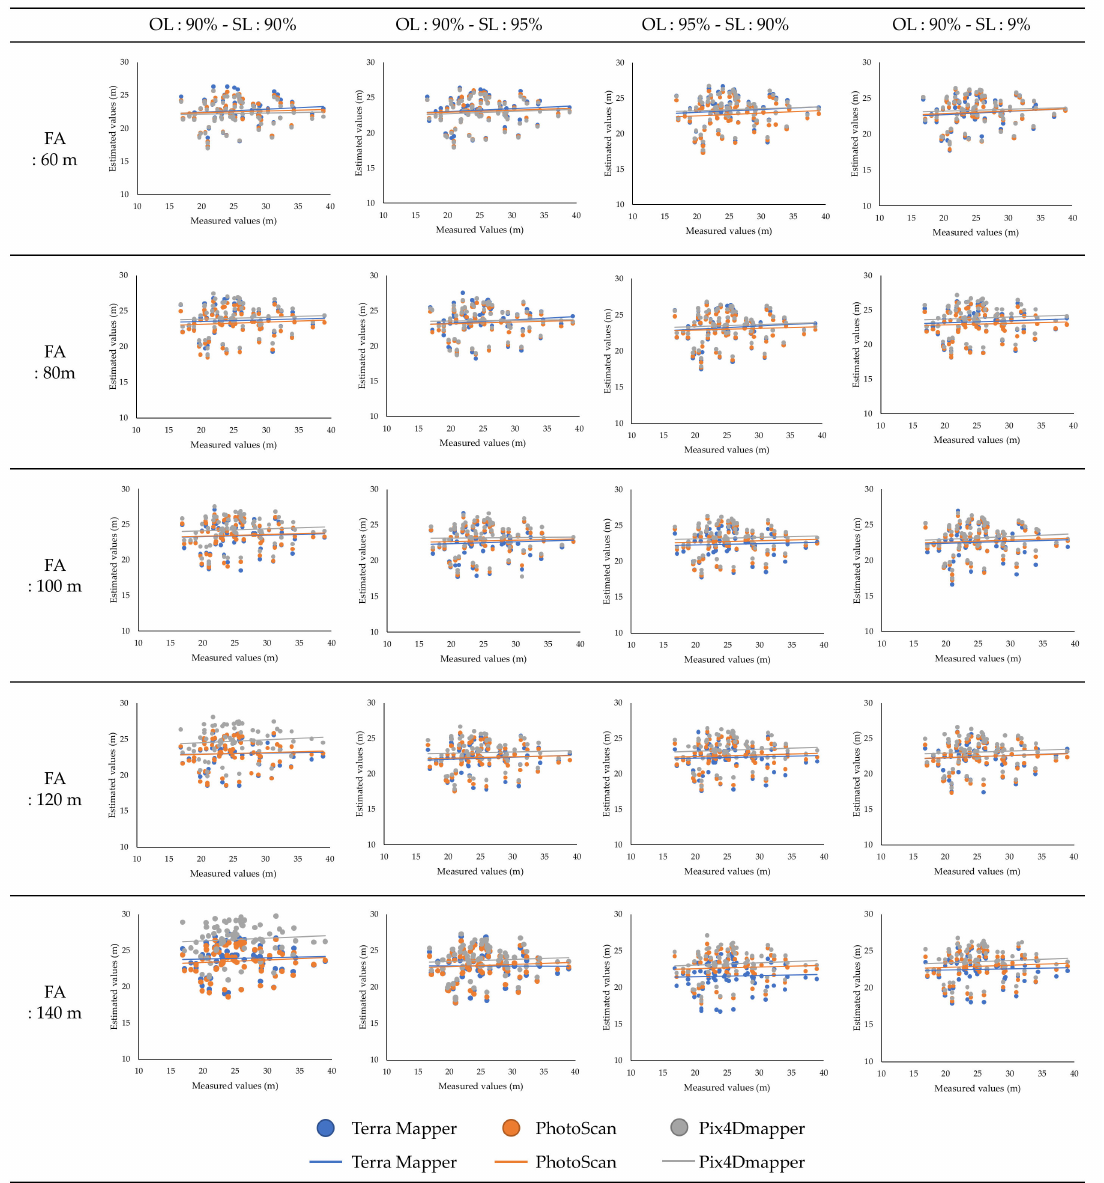
Figure 8. Comparison of estimated and measured tree heights and regression line for each SfM